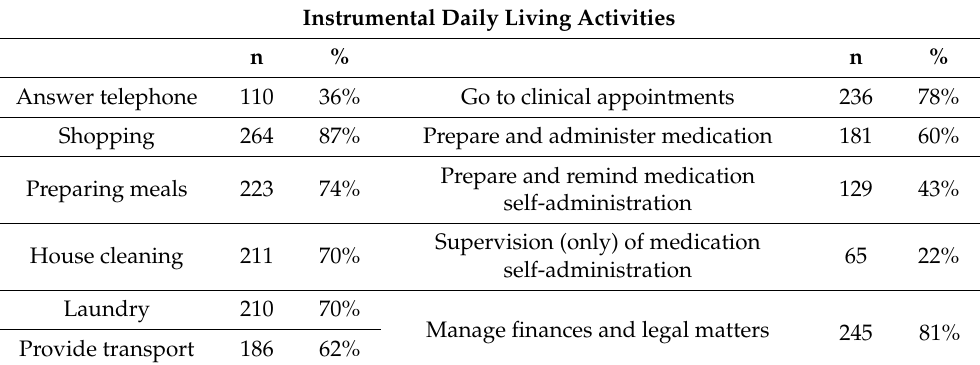
Table 3. Caregivers’ support for the cared-for person’s instrumental daily living